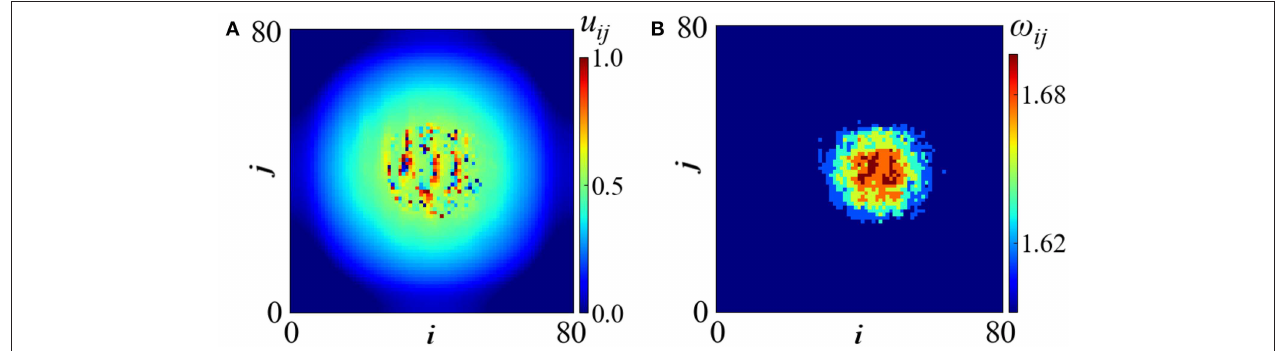
FIGURE 6 | Single mobile spot in random fractal connectivity. Parameters are σ = 0.2 and T r = 0.5. All other parameters are as in Figure 2A . Simulations start from random initial conditions.